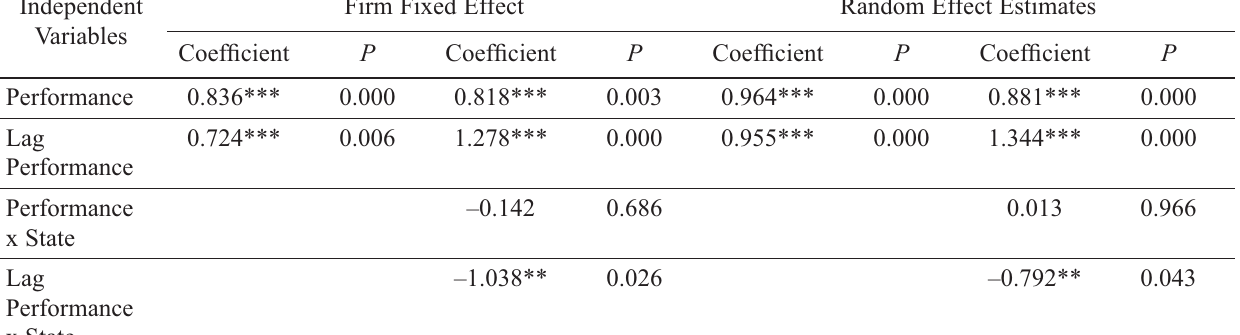
Table 8. CEO compensation and fi rm performance at China’s listed fi